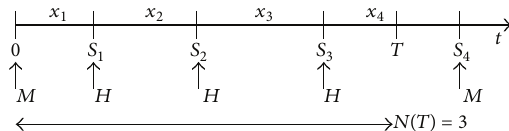
Figure 4: Renewal model for query